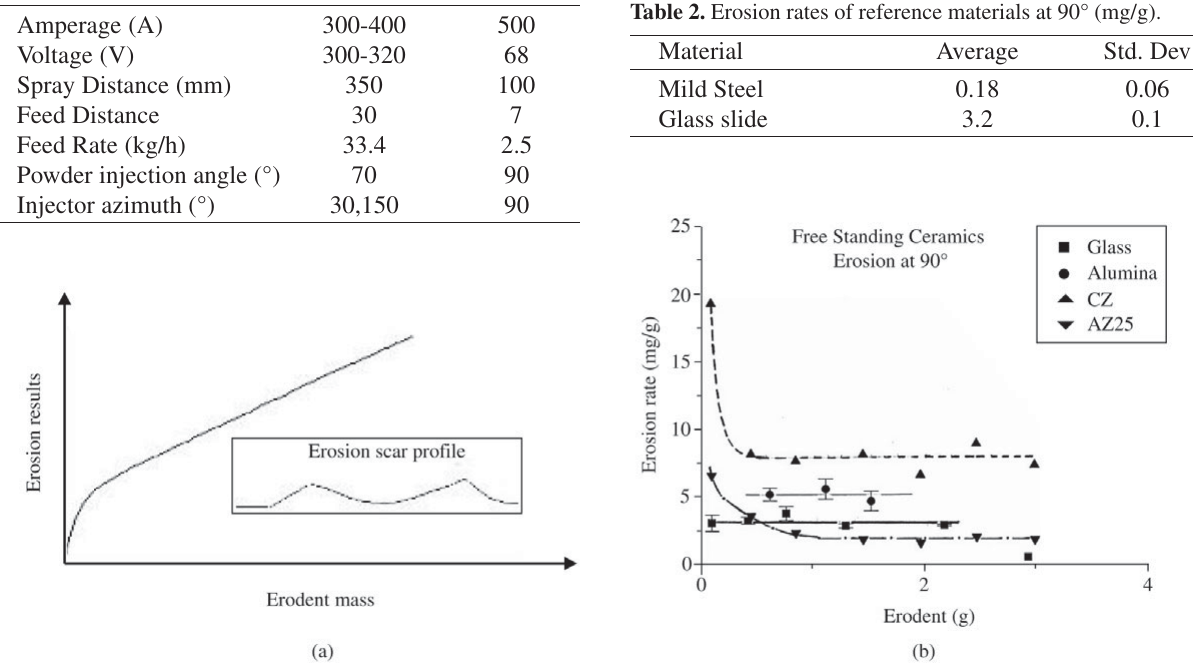
Figure 1. Erosion results. a) Schematic representation of a typical incremental erosion weight loss and 2D scar profile; b) Erosion rates of soda-lime glass, alumina, calcia-zircônica (CZ) and alumina-25 wt.% zirconia